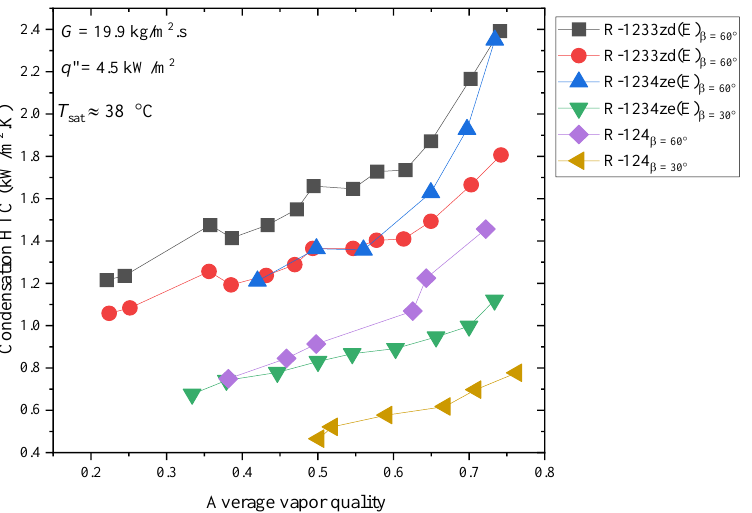
Figure 12. Condensation HTC of low-GWP refrigerants inside the plate heat exchanger with different chevron angles. Rectangular and solid connected line presents the Known et al. [66] and Shon et al. [67] study respectively, triangular upward and downward solid connected lines presents the Jung et al. [68] study, star and triangular backward study presents the Ko et al. [69] study.